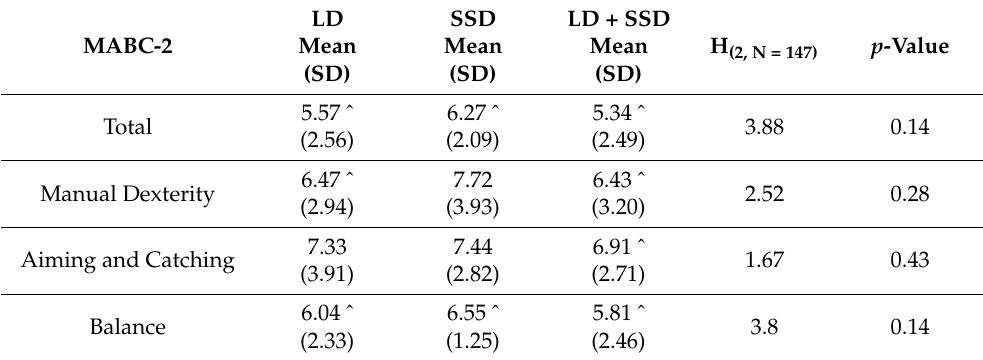
Table 3. Mean, SD, Kruskal–Wallis H and p -value for Total, Manual Dexterity, Aiming and Catching, and Balance tasks by groups.